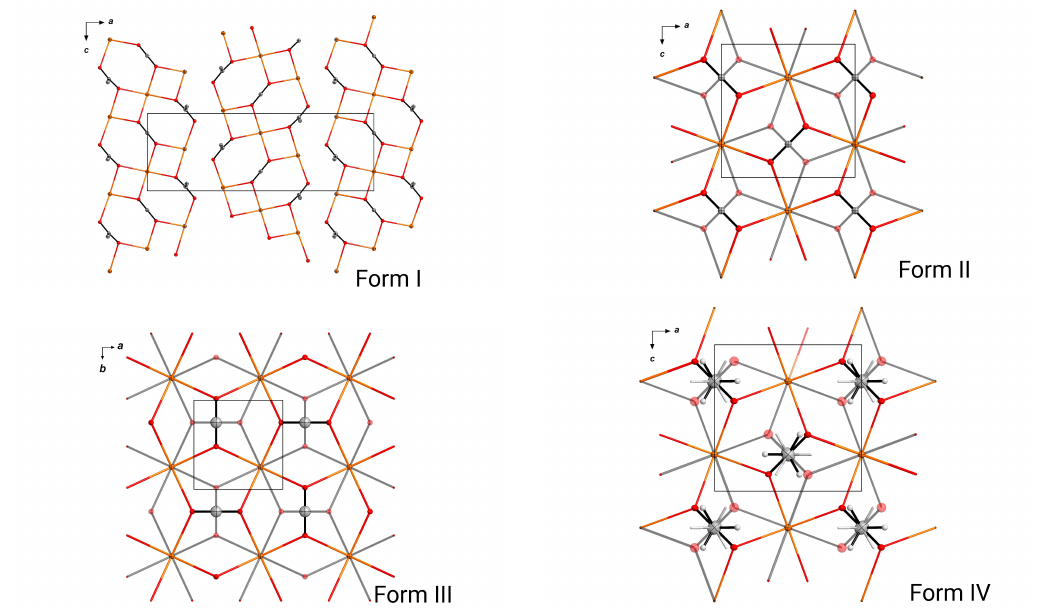
Figure 1. Crystal packing of all four structures as generated with DIAMOND [24]. Form I (top left) and II (top right) show decreased ordering at higher temperature. Tetragonal Form III (smaller unit cell, bottom left) and orthorhombic Form IV are structurally rather similar; Forms II and IV differ by another layer below the visible plane that is not shown. Grey bonds represent the less occupied site in case disorder in the carboxylate group